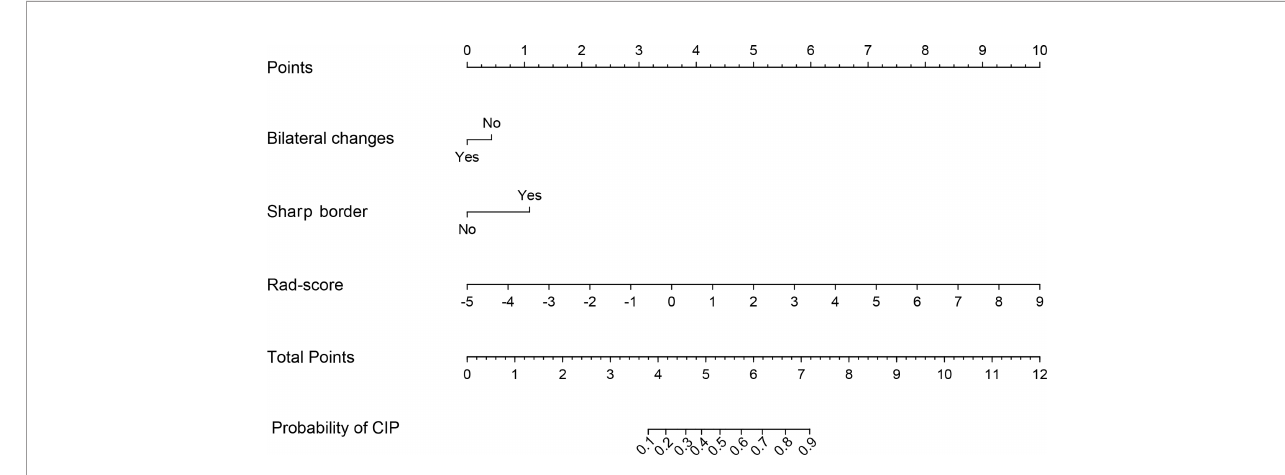
FIGURE 5 | Nomograms constructed in this study using the training dataset.